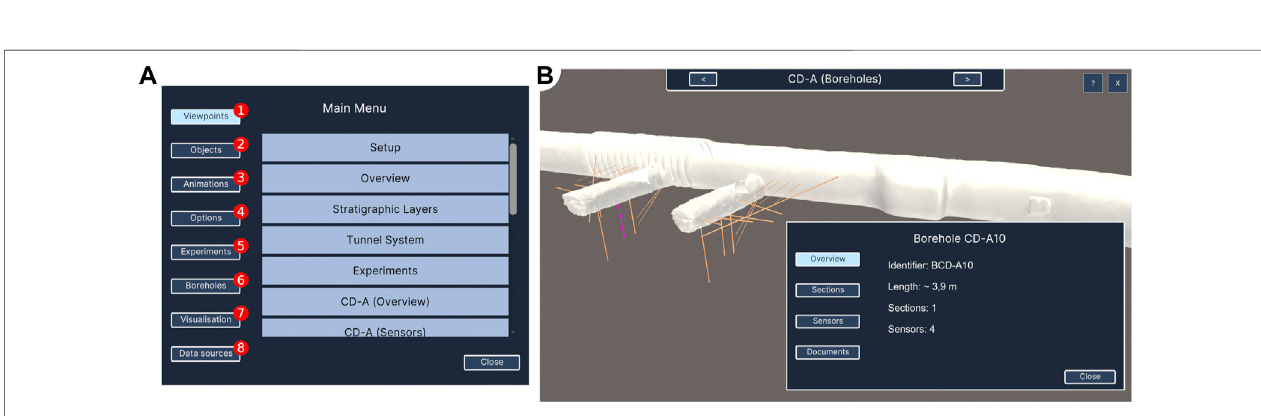
FIGURE 13 | Important windows in our application (A) the Main Menu and (B) the Borehole Panel , exemplary for borehole CD-A10.